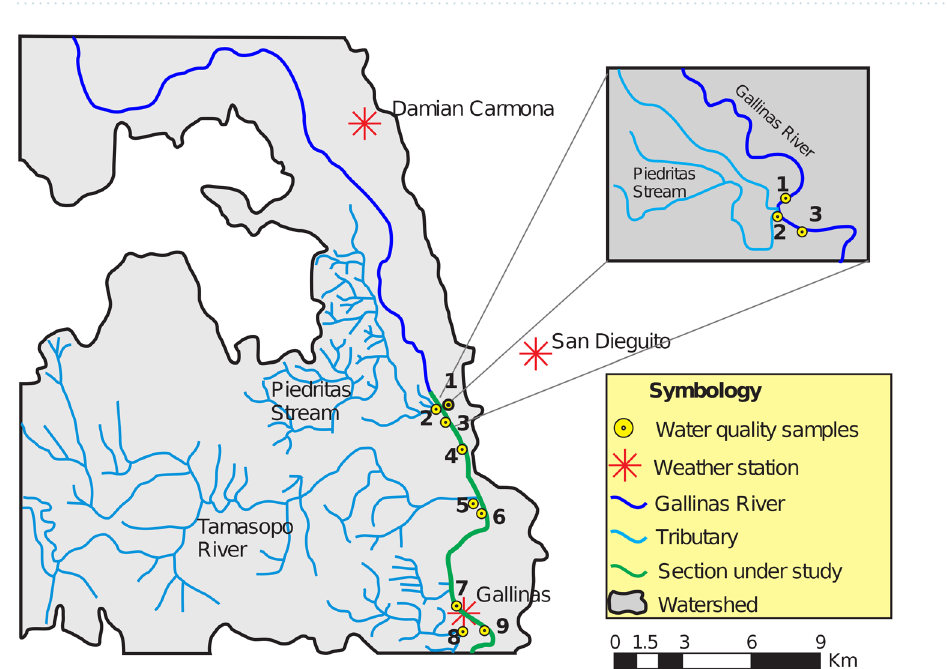
Figure 2. Sampling points location. The maps were designed with Inkscape 1.0.2 (http:// inksc ape. org), based on